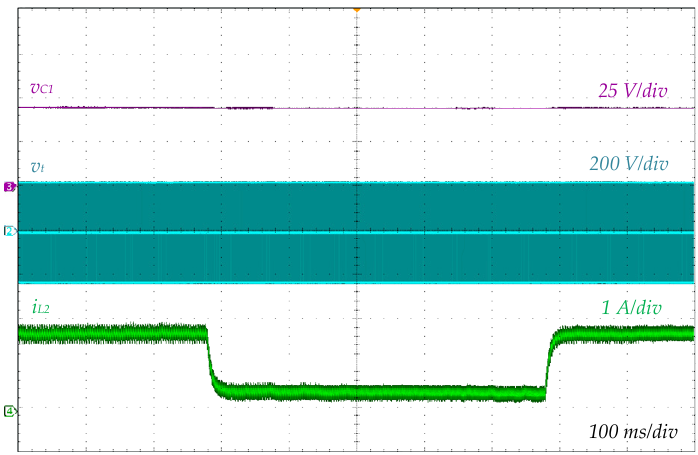
Figure 13. Closed-loop response of converter CFDAB controlling the battery charge current.